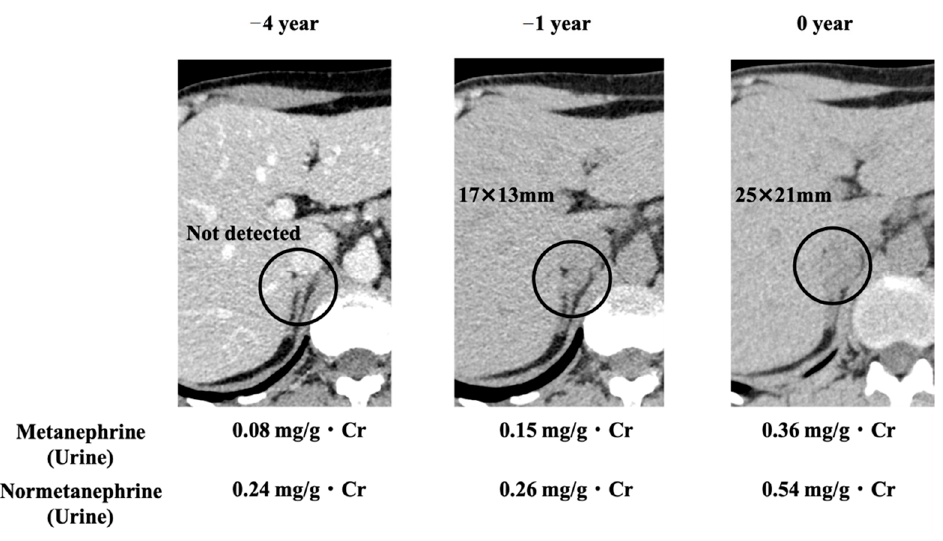
Figure 2. Pathological findings of left adrenal tumors resected from the patient. ( A ) Hematoxylin- eosin (HE) staining of the left adrenal gland (circles show the location of the two tumors); ( B ) MAX staining of the left adrenal gland; ( C ) Chromogranin A staining of the left adrenal gland; ( D ) Hema- toxylin and eosin staining of tumor 1 (rectangular area in the tumor 1); ( E1 ) MAX staining in tumor 1 (rectangular area in the tumor 1); ( E2 ) Rectangular area in panel E1. Pheochromocytoma (PCC) cells in the adrenal medulla show no MAX staining (arrows); ( F ) HE staining of tumor 2 (rectangular area in the tumor 2); ( G1 ) MAX staining in tumor 2 (rectangular area in the tumor 2); ( G2 ) Left rectangular area in panel G1. Adrenal cortex cells show MAX staining (arrowheads); ( G3 ) Right rectangular area in panel G1. The PCC cells show no MAX staining (arrows).